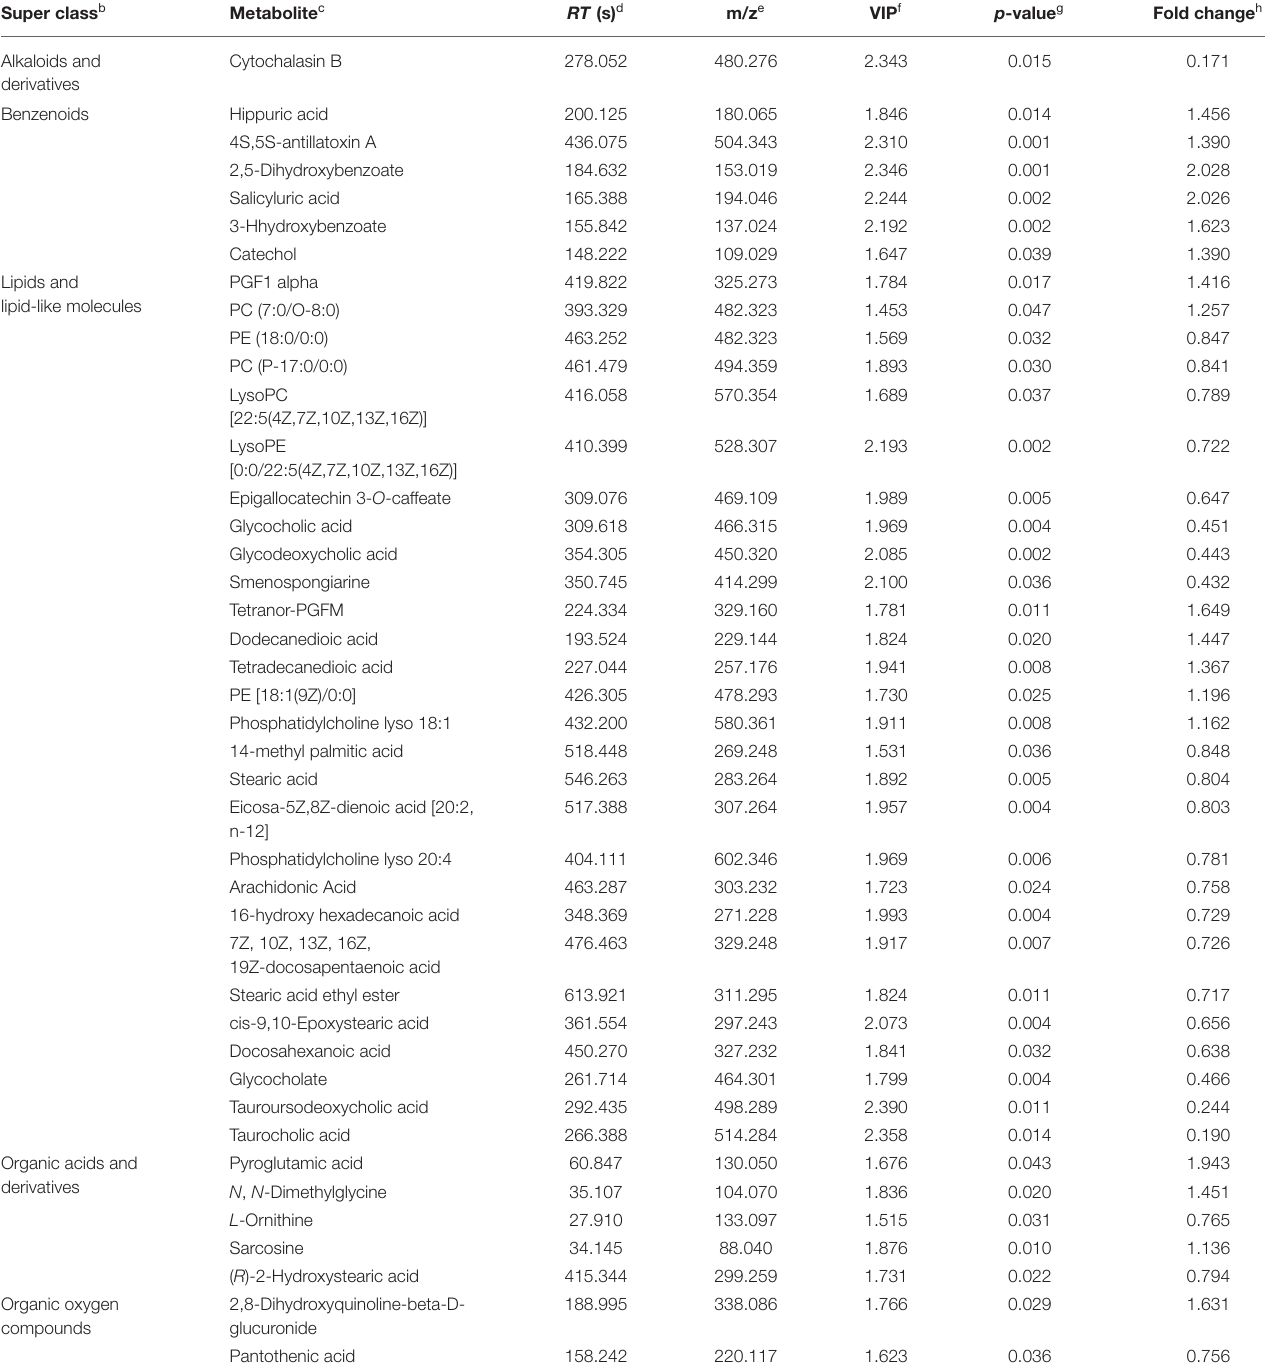
TABLE 7 | HMDB compound classification of differential metabolites of plasma between NCG group and CON group a . Super class